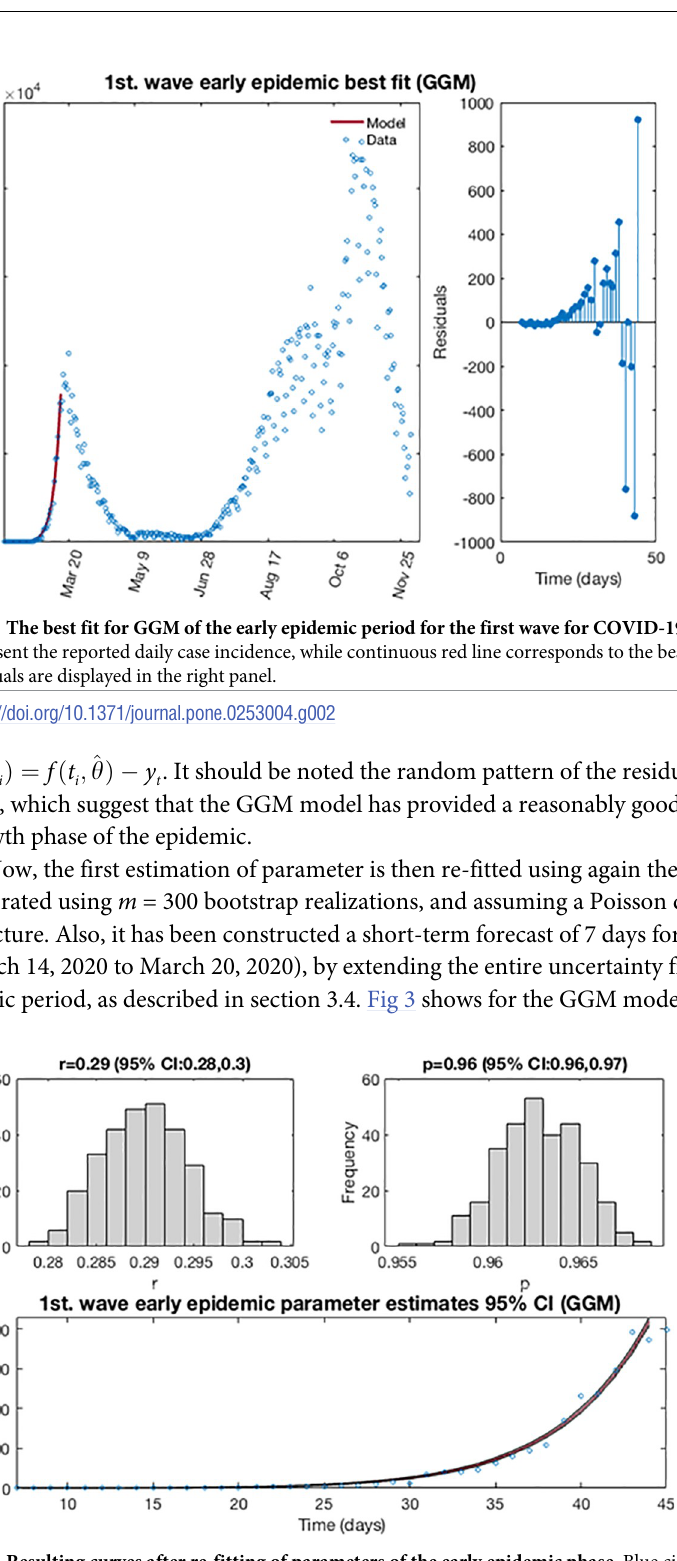
Fig 3. Resulting curves after re-fitting of parameters of the early epidemic phase. Blue circles are the cases reported daily; red line corresponds to the best fit of the GGM to the data. Grey lines correspond to the m bootstrapping realizations of the epidemic curves. Black lines correspond to the 95% CI bounds. The empirical distributions for parameter estimations are displayed in the top panel.